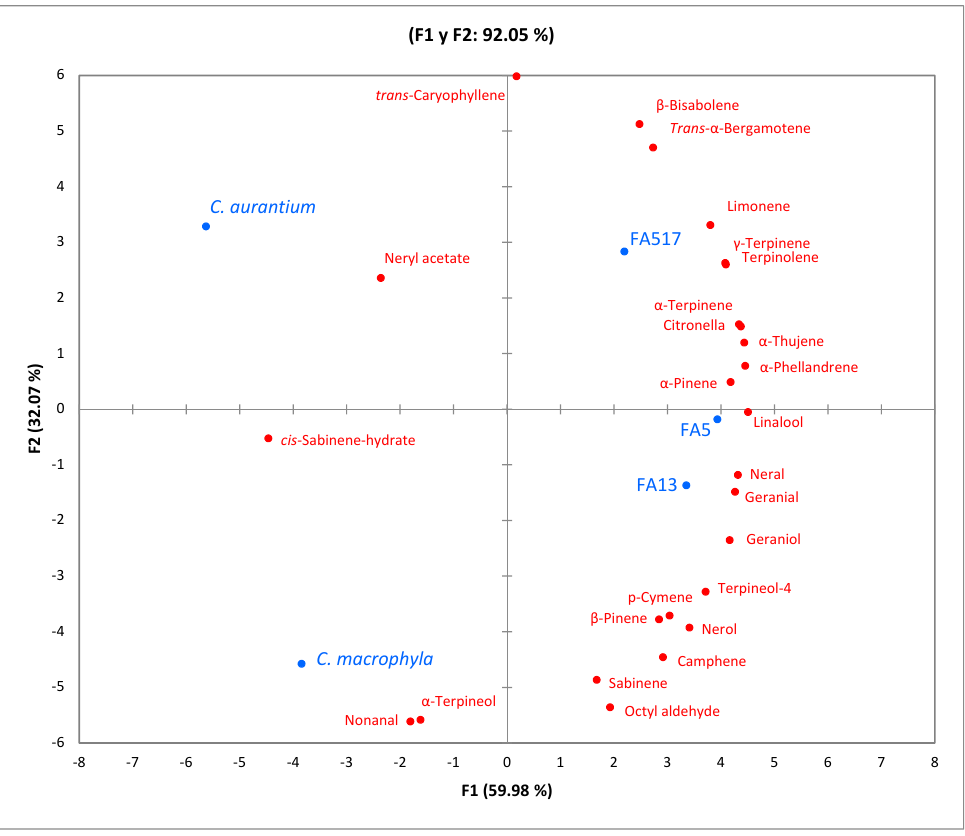
Figure 1. Principal component analysis (PCA) plot showing the relationships among volatile Figure1. Principalcomponentanalysis(PCA)plotshowingtherelationshipsamongvolatilecompounds compounds and the factor “rootstock” ( n = 9). and the factor “rootstock” ( n =